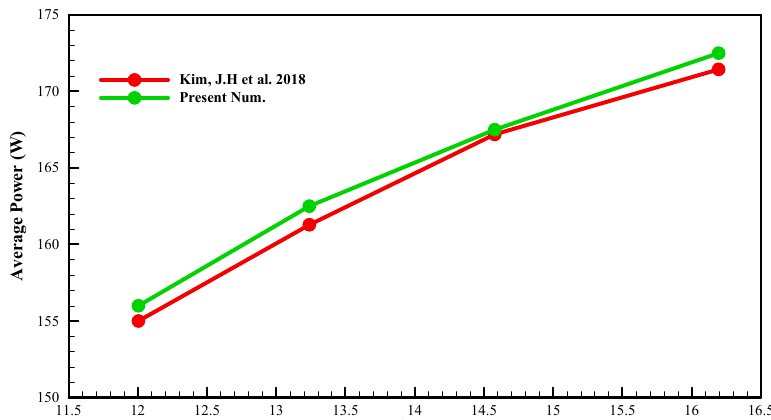
Figure 7. Comparison of change in power with the tooth thickness in the present numerical model and that in Ref. [11].